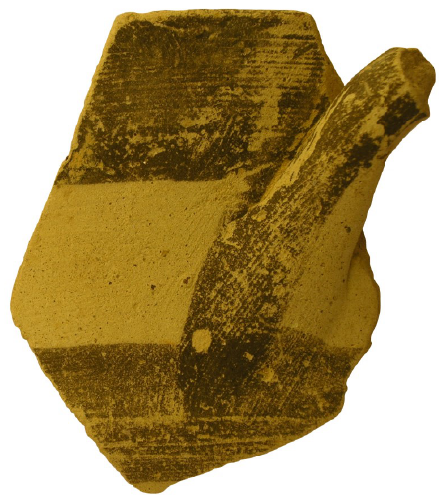
Figure 14. White Painted I bowl fragment from the sanctuary at Agia Irini, AIS 0780.003, H. 5.1 cm, © Medelhavsmuseet.